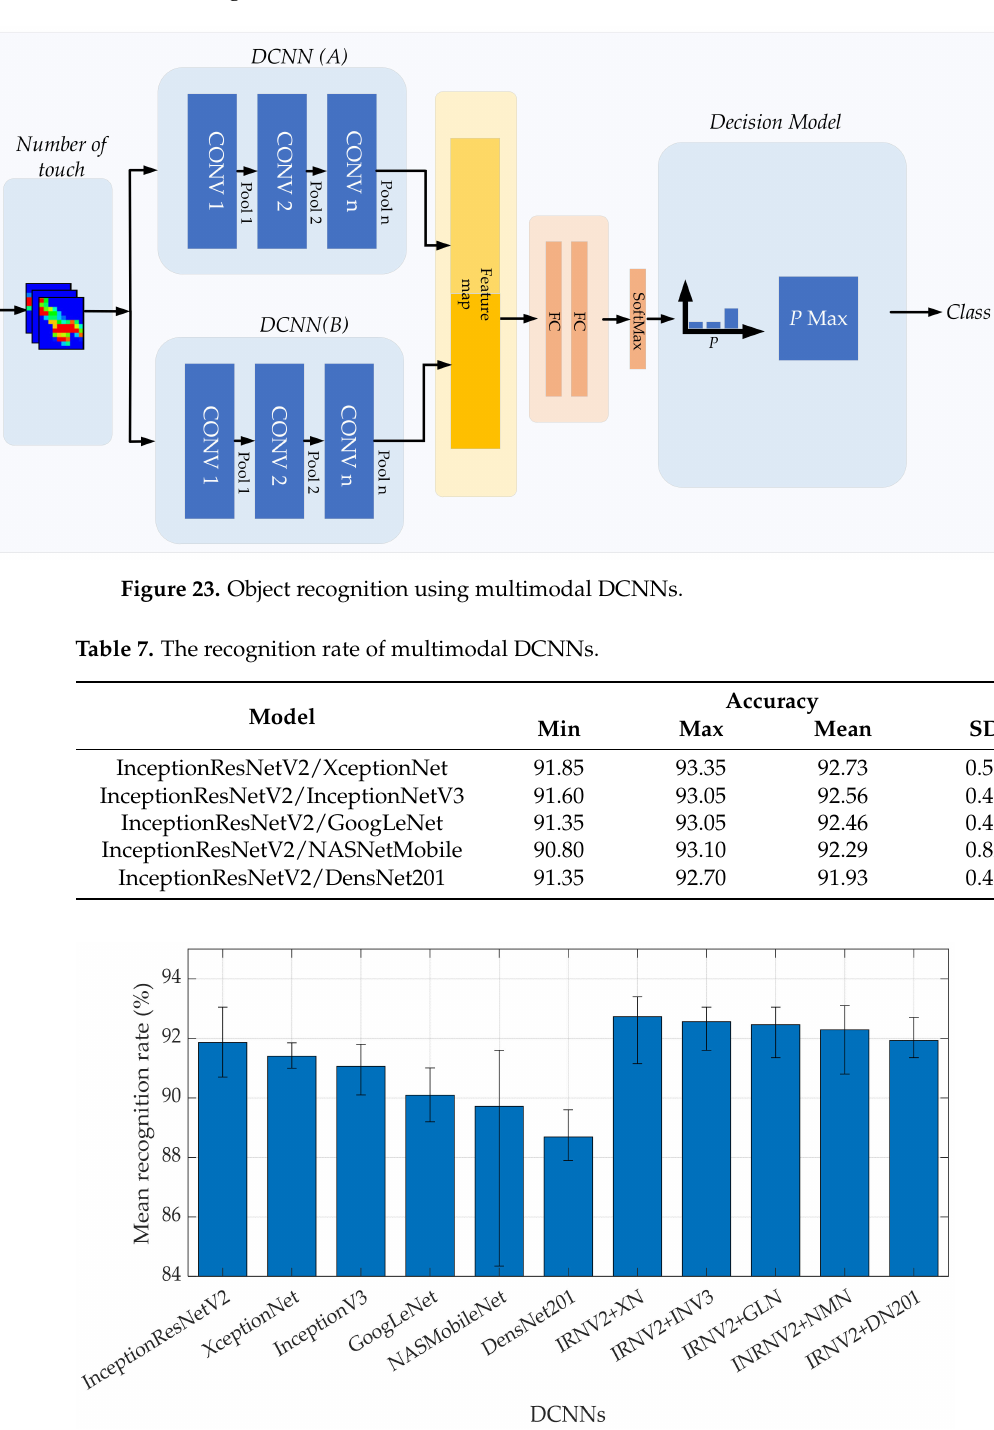
Figure 24. The recognition rate of single DCNNs and Multimodal